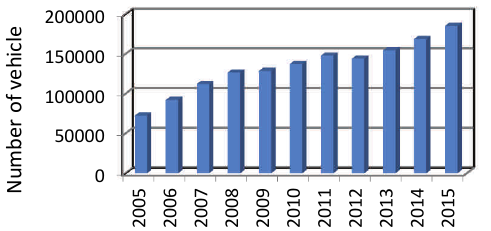
Fig. 2. Haulage work performed by the Polish international freight road transport against the background of international transport haulage work in other EU countries [bln tkm] (diagram based on CSO data [5])